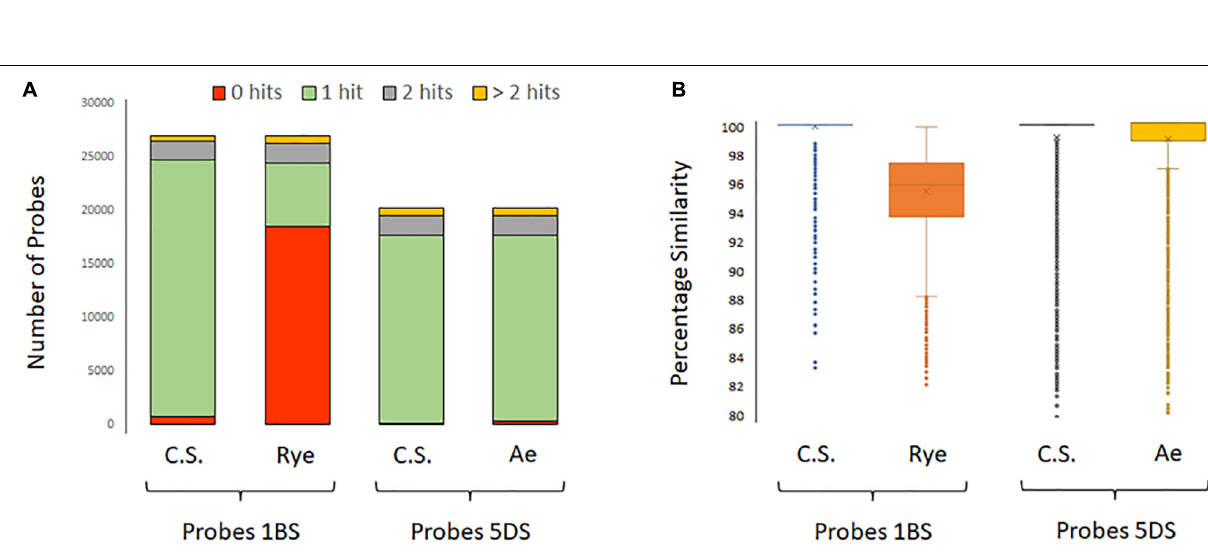
Frontiers in Plant Science |